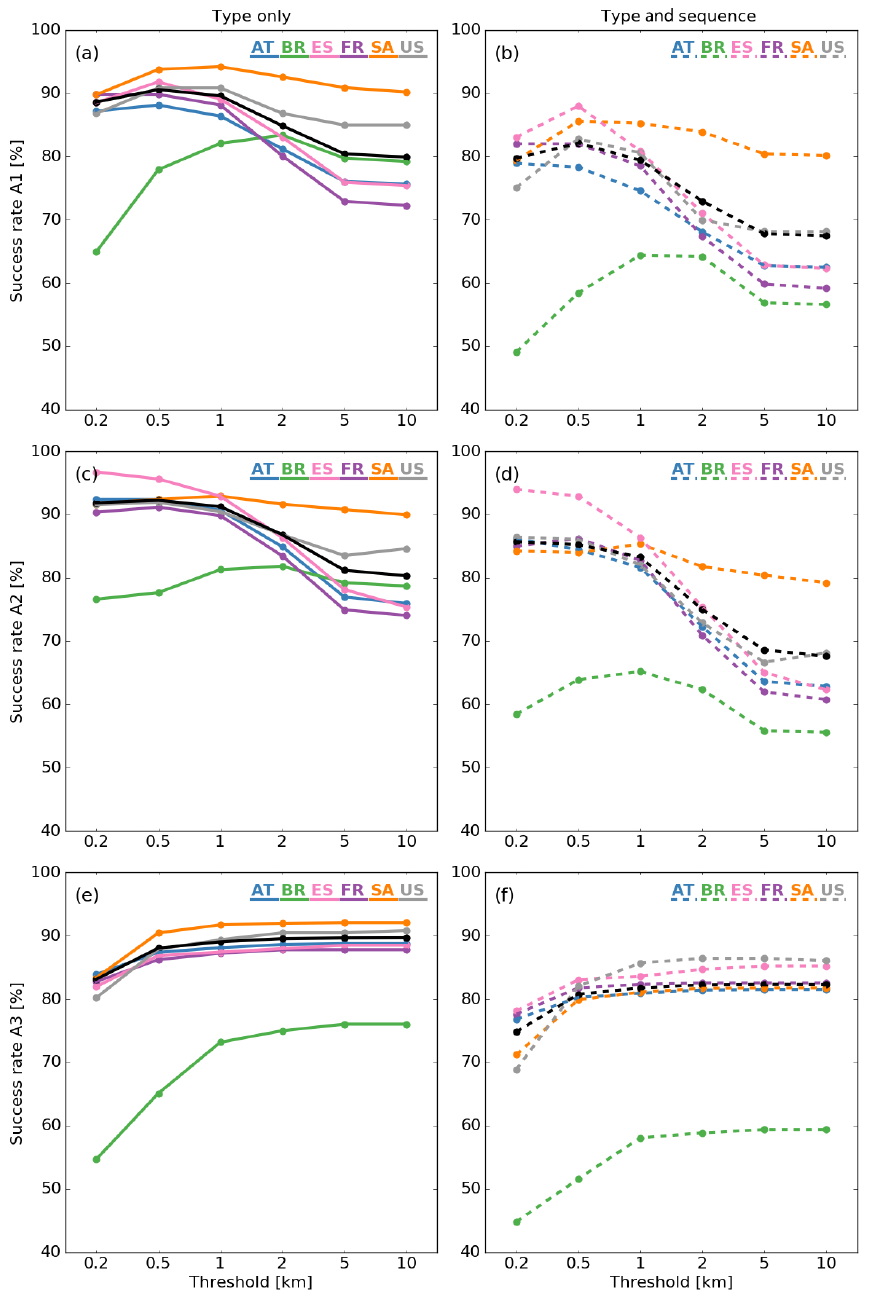
Figure 2. The success rate for the three algorithms is displayed in the type-only case (a, c, e) and the type-and-sequence case (b, d, f) for algorithm A1 (a, b) , A2 (c, d) and A3 (e, f) . Colors are linked to each specific data set, whereas the black curve indicates the average result without